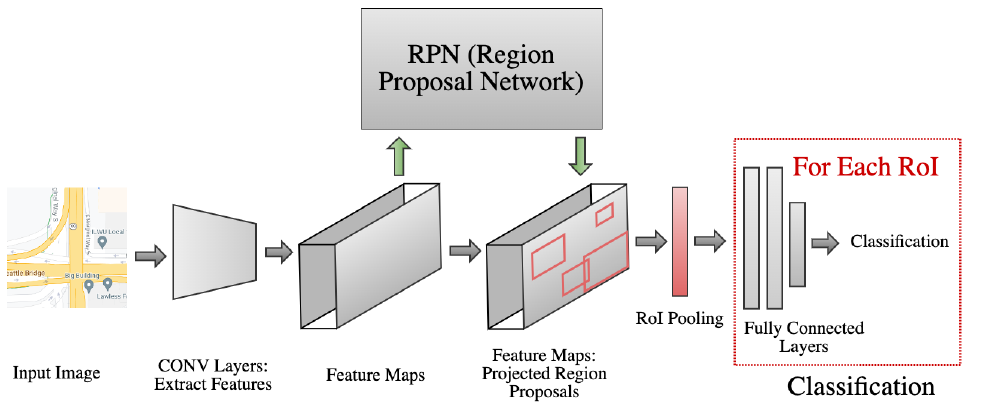
Figure 2. Faster R-CNN high level